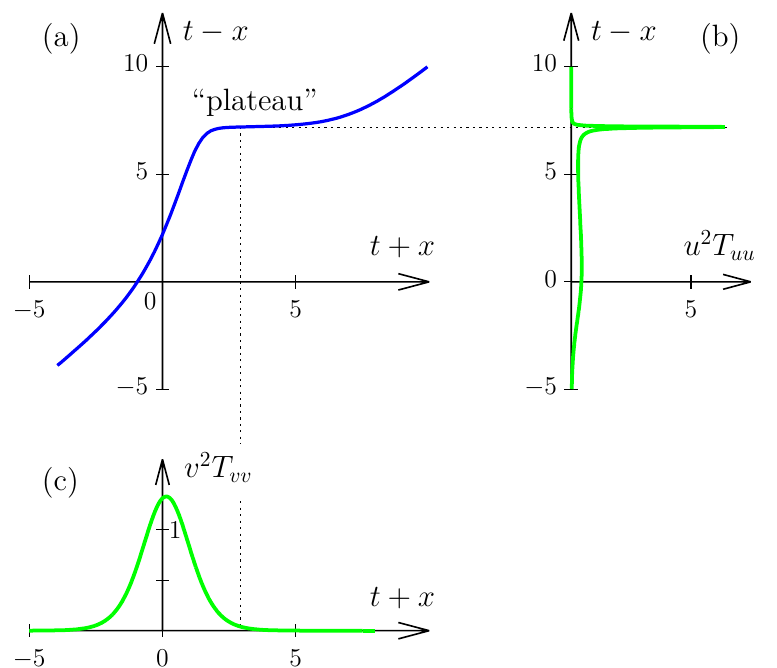
Figure 9 . Solution (3.15) at almost critical values of parameters s = b = e (cid:0) 2 (cid:30) 0 = 1 and a = p a cr (cid:0) 10 (cid:0) 3 , where a cr = (cid:0) 1 = 3 and we use units with (cid:21) = 1. In this case C (cid:25) 7 (cid:2) 10 (cid:0) 4 (cid:28) 1. Figure (a) shows the boundary u = U ( v ) in the asymptotically (cid:13)at light-cone coordinates t + x = log( (cid:21)v ) =(cid:21) , t (cid:0) x = (cid:0) log( (cid:0) (cid:21)u ) =(cid:21) , see eq. (2.11). In (cid:12)gures (b), (c) we plot the outgoing and incoming energy (cid:13)uxes u 2 T uu and v 2 T vv as functions of t (cid:0) x and t + x ,